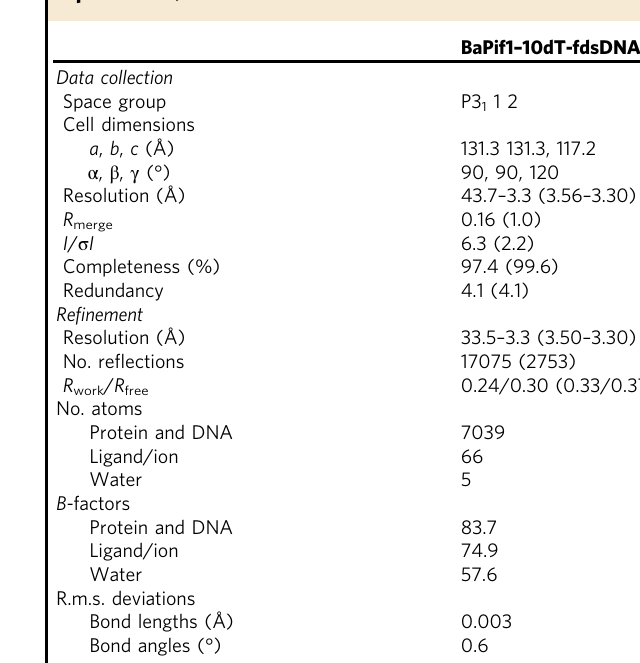
Table 1 Data collection and re fi nement statistics (molecular